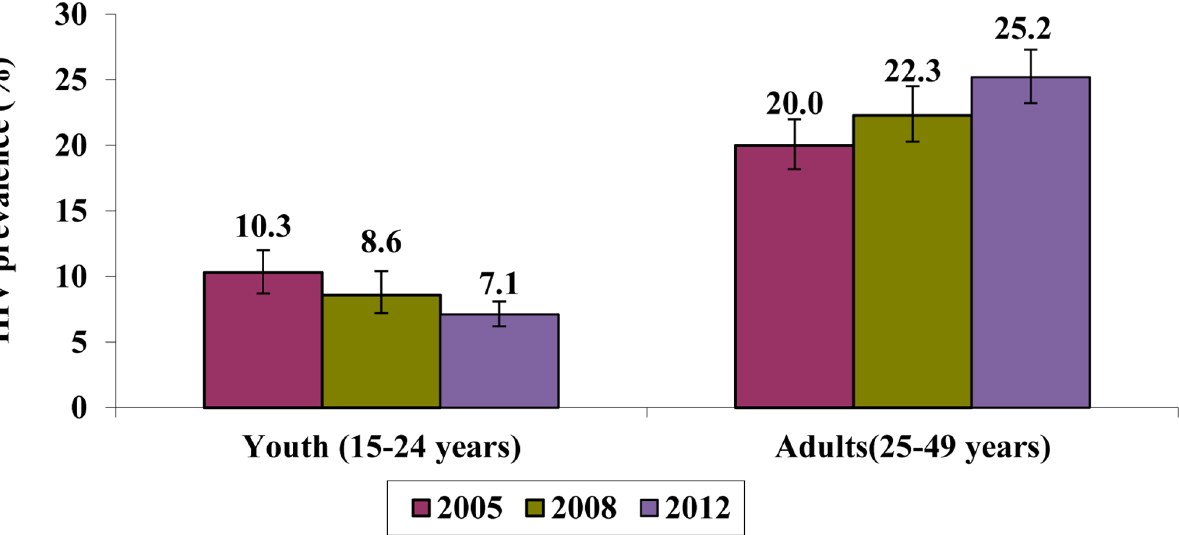
Fig 2. HIV prevalence trends by age group and survey year, South Africa 2005 – 2012. HIV prevalence among youth aged 15 – 24 years and adults aged 25 – 49 years estimated in the years 2005, 2008 and 2012. Source: Human Science Research Council Surveys [3].